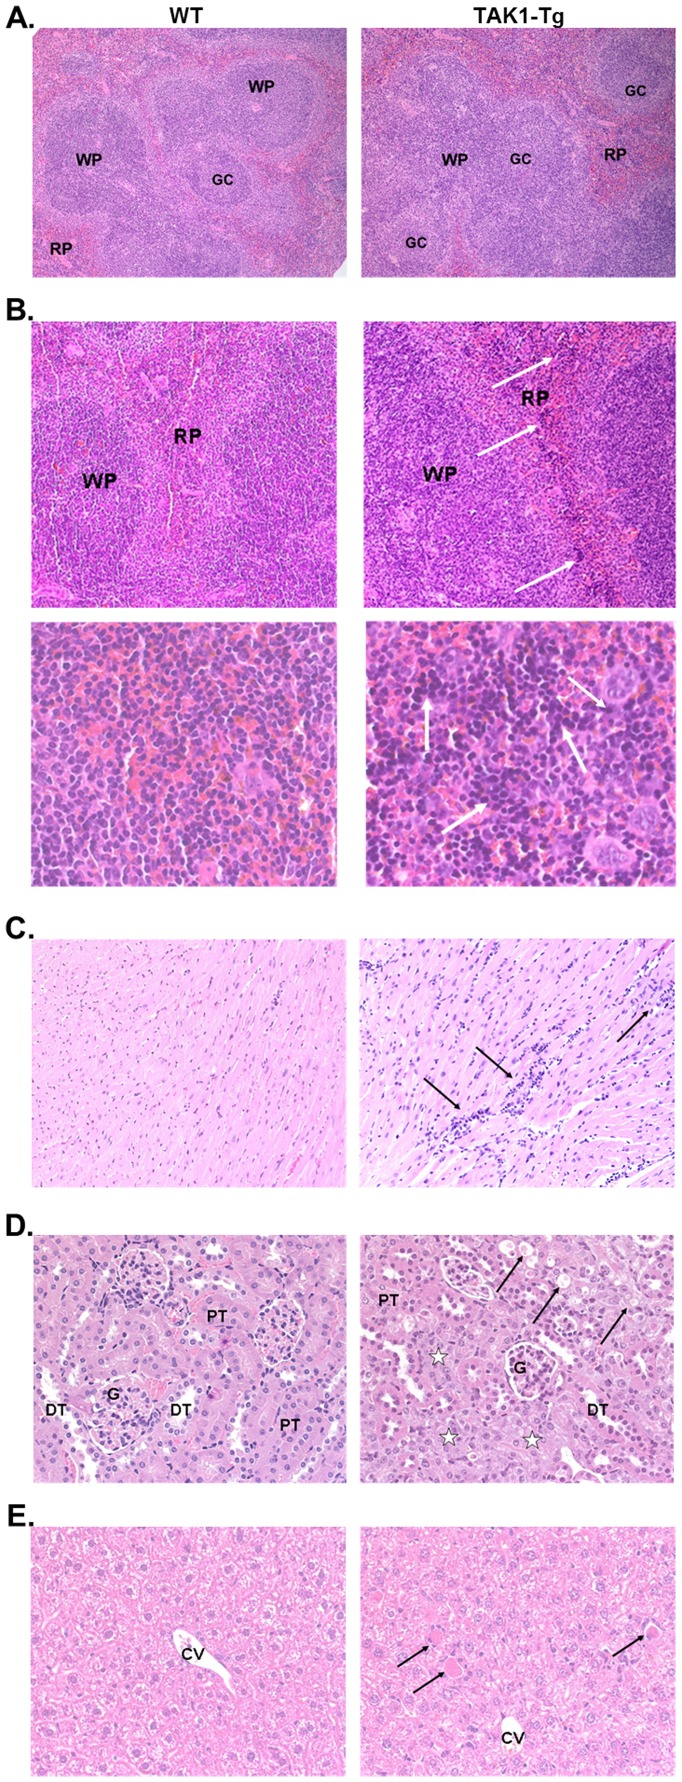
TAK1 knockdown causes histopathological changes in spleen, heart, kidneys and liver.Wild type (WT) and TAK1 shRNA transgenic mice (TAK1-Tg) were treated with 0.2 mg/ml doxycycline in the drinking water for five weeks. At autopsy, anaesthetized mice were sacrificed and organs and tissues were dissected and processed for histopathological examination (Formalin-fixed and HE-stained). A. Spleen (Obj. 10x). Left, WT: normal histological appearance of the spleen with white pulp (WP) comprising germinal centers (GC) and red pulp (RP). Right, TAK1-Tg: increase in cellularity of the B-cell areas and in germinal center development in the follicles. B. Spleen. Obj. 10x (top) and Obj. 40x (bottom). Left, WT: normal histological appearance of the spleen with white pulp (WP) and red pulp (RP); no extramedullary erythropoiesis. Right, TAK1-Tg: moderate increase in extramedullary erythropoiesis in the red pulp (arrows, top) showing increased numbers of erythroblasts (white arrows, bottom) and megakaryocytes (black arrows, bottom). C. Heart. Obj. 10x. Left, WT: normal histological appearance of the heart with intact muscle fibers. Right, TAK1-Tg: scattered slight muscle fiber degeneration and necrosis accompanied with inflammatory cells (arrows). D. Kidney. Obj. 40x. Left, WT: normal histological appearance of the kidney (cortex) with glomeruli (G), proximal (PT) and distal (DT) tubules. Right, TAK1-Tg: diffuse marked degeneration (arrows) and regeneration (asterisks) of the proximal tubular cells. E. Liver. Obj. 40x. Left, WT: normal histological appearance of the liver in the centrilobular region next to the central vein (CV). Right, TAK1-Tg: scattered several to many hepatocytes showing single cell necrosis (arrows).